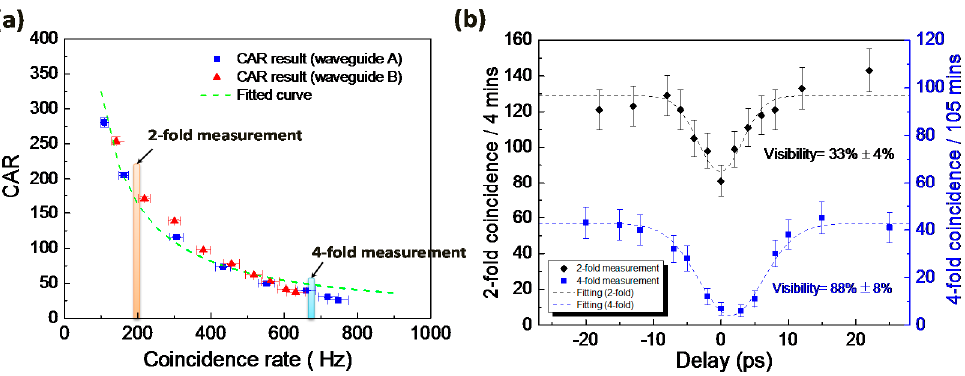
Figure 3. ( a ) coincidence to accidentals ratio (CAR) vs. coincidence rate. Blue rectangles: CAR measurement results in waveguide A; red triangles: CAR measurement results in waveguide B; green dashed line: analytical plot. Light red bar shows the experimental condition of two-fold HOM dip measurement, and light blue bar points the experimental condition of the four-fold HOM dip measurement; ( b ) two-fold and four-fold HOM dip experimental results. Black diamonds: two-fold experimental result; black dashed line: fitted curve using a Gaussian function. Blue rectangles: four-fold experimental results; blue dashed line: fitted curve using a Gaussian function.